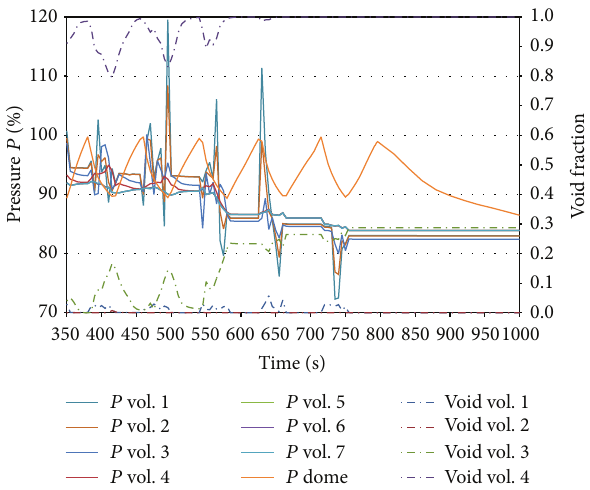
Figure 8: Pressure and void fraction evolution in containment before and after start of ECCS.